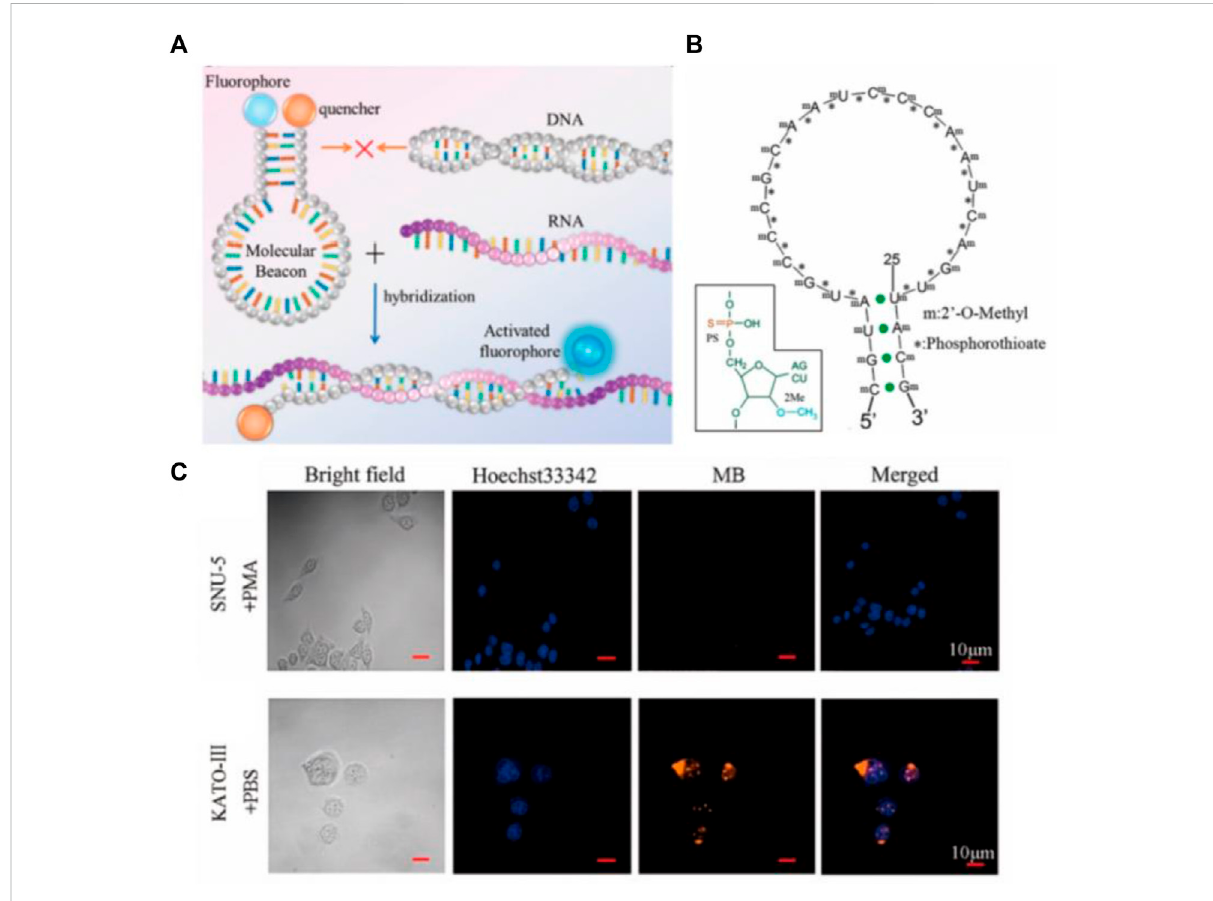
FIGURE 2 (A) Working mechanism of MB hybridization reaction with target. (B) Schematic diagram of MB modi fi ed with thiophosphoric acid and 2 ′ -o- methyl. (C) In situ imaging of CLDN18.2 RNA in cells by MB (Fan et al., 2021). Copyright 2021 American Chemical